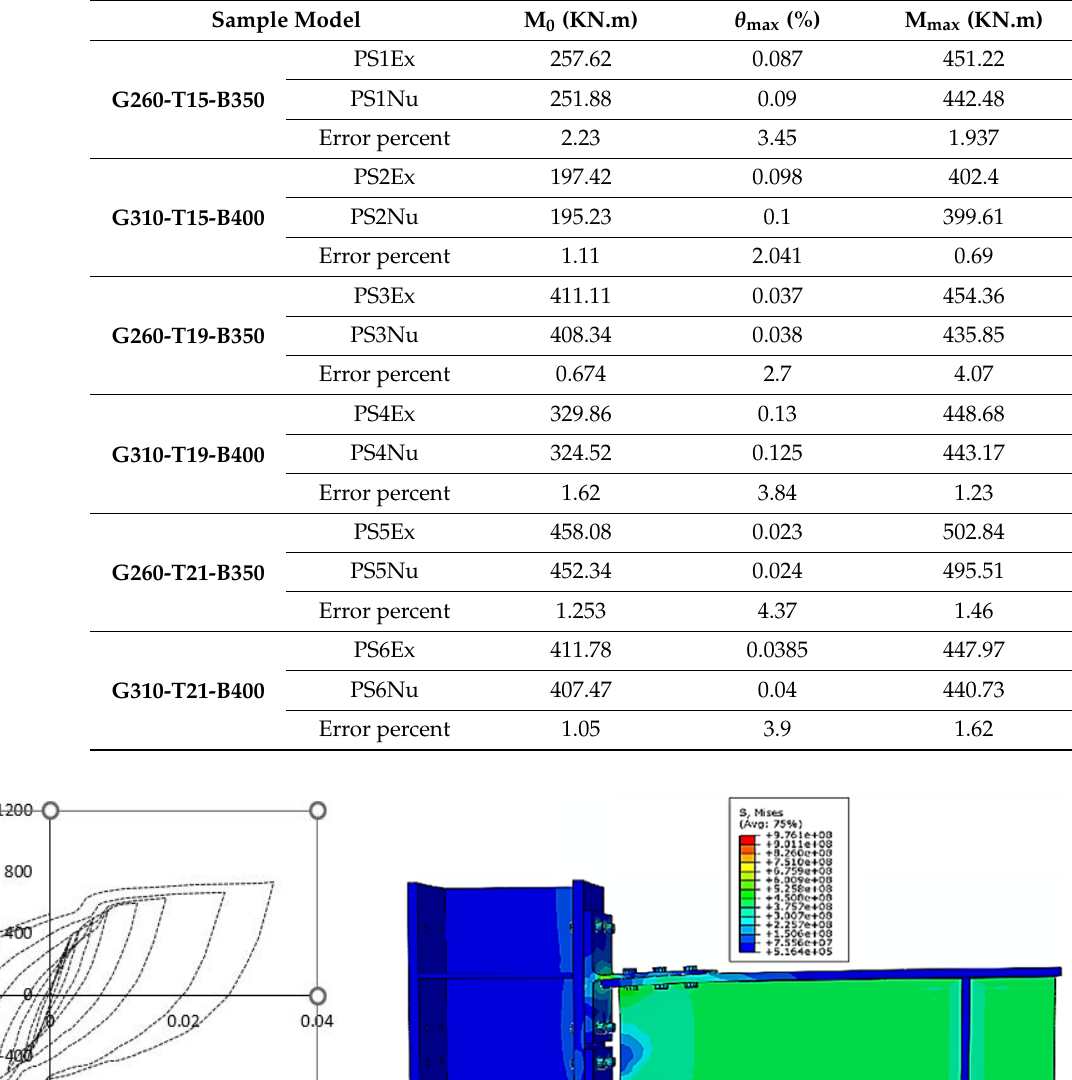
Table 2. Comparing experimental results with numerical modeling results.